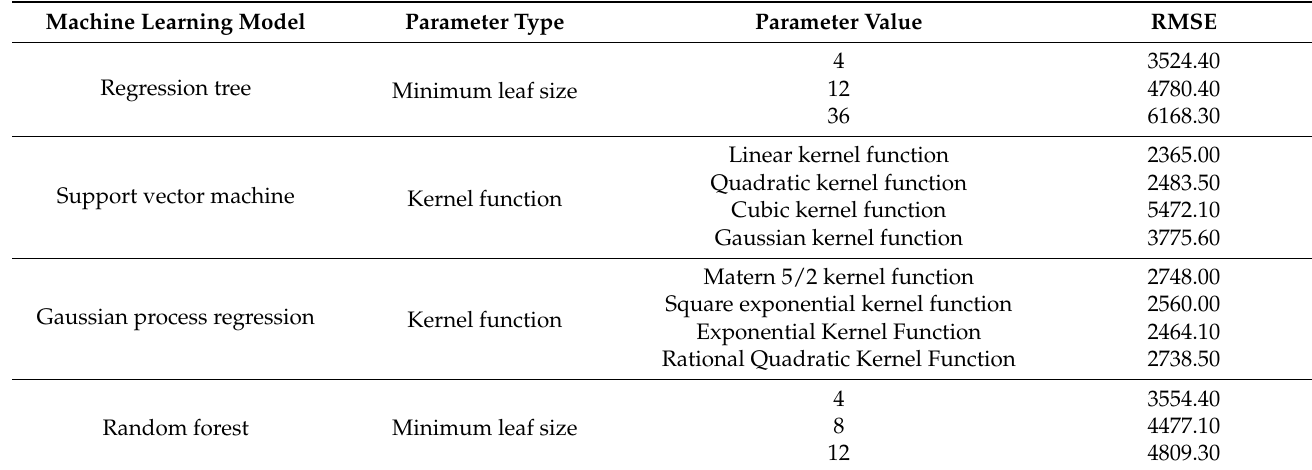
Table 3. RMSE of different parameters of machine learning regression model of tertiary industry